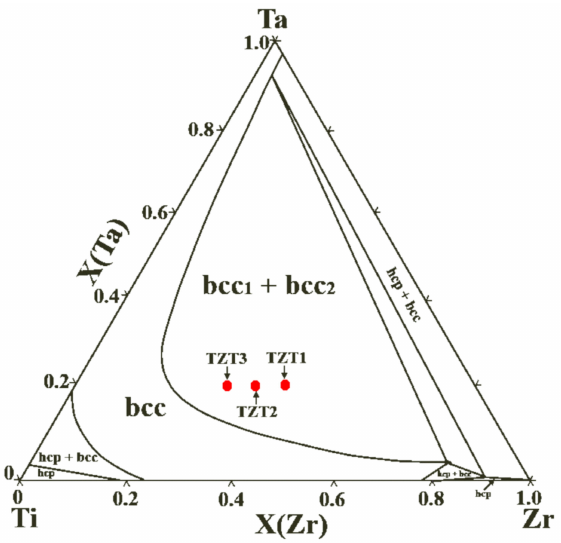
Figure 1. Isothermal cross section at 973K of the phase diagram of the ternary Ti-Zr-Ta alloy